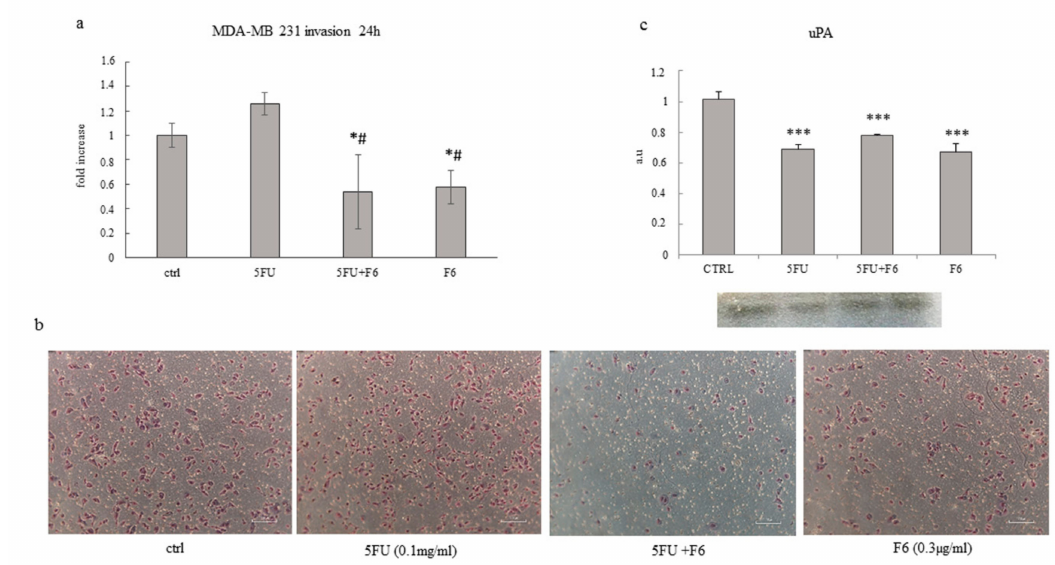
Figure 3. E ff ect of 5FU, 5FU + F6, and F6 on invasion in MDA-MB-231 cells. Transwell invasion assay ( a , b ) and urokinase plasminogen activator (uPA) levels ( c ) was performed in MDA-MB-231 cells untreated (ctrl) and treated with 5FU, 5FU + F6, and F6 for 24h. Values, expressed as fold increase of control value considered as 1, are means of three independent experiments performed in duplicate, with SD represented by vertical bars. * p < 0.05; *** p < 0.001 versus ctrl; # p < 0.05 versus 5FU by ANOVA followed by Bonferroni post-test. Images were obtained by optical microscopy, with 100 × magnification.